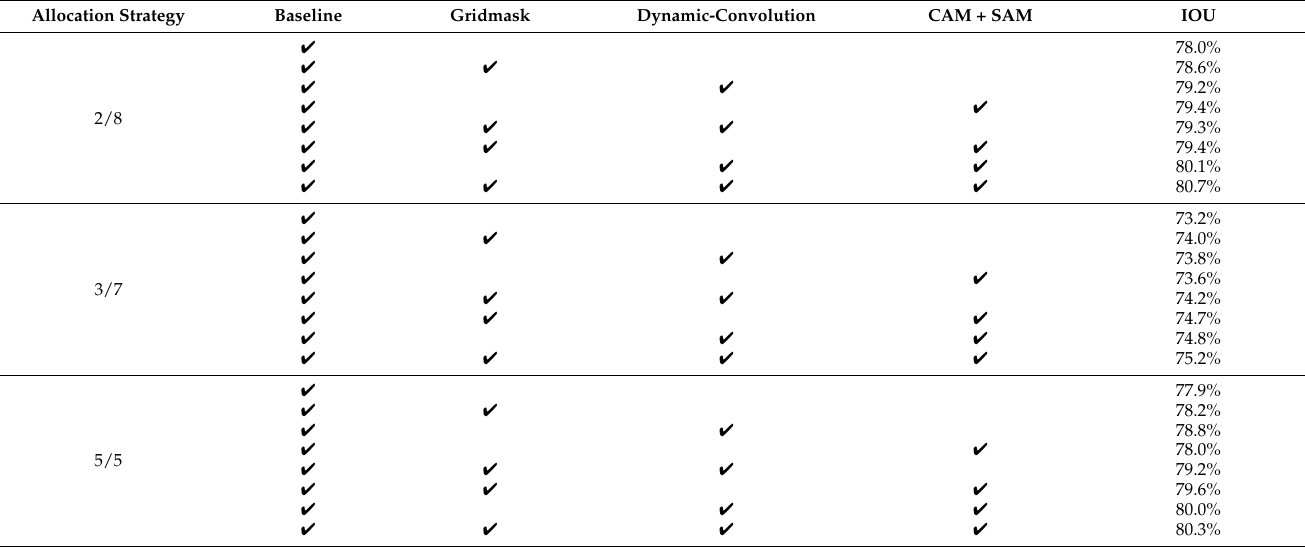
Table 4. Results of ablation study on the Corsican dataset. ( (cid:52) denotes the module is included in the